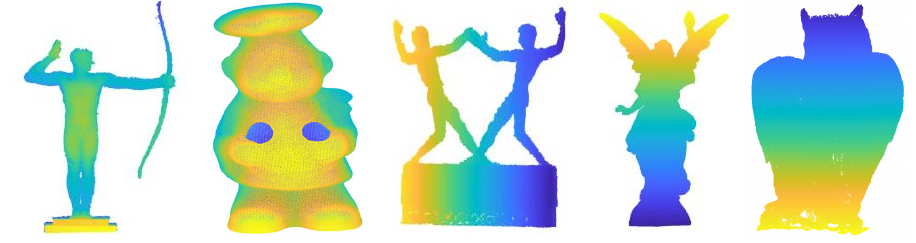
Figure 1. The original 3D models. Archer, Chef, Kids, Lucy and